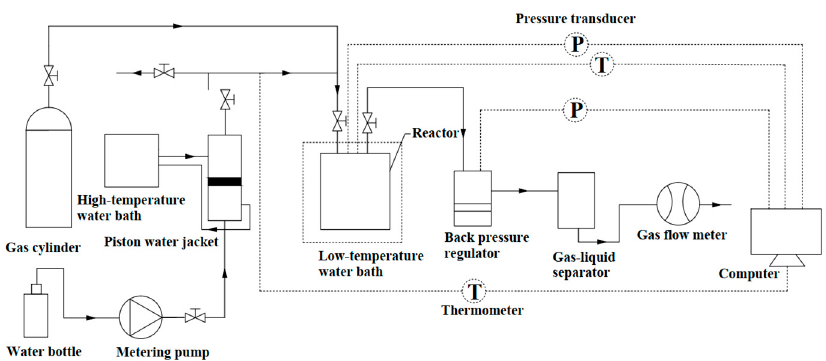
Figure 1. Schematic of the experimental apparatus.